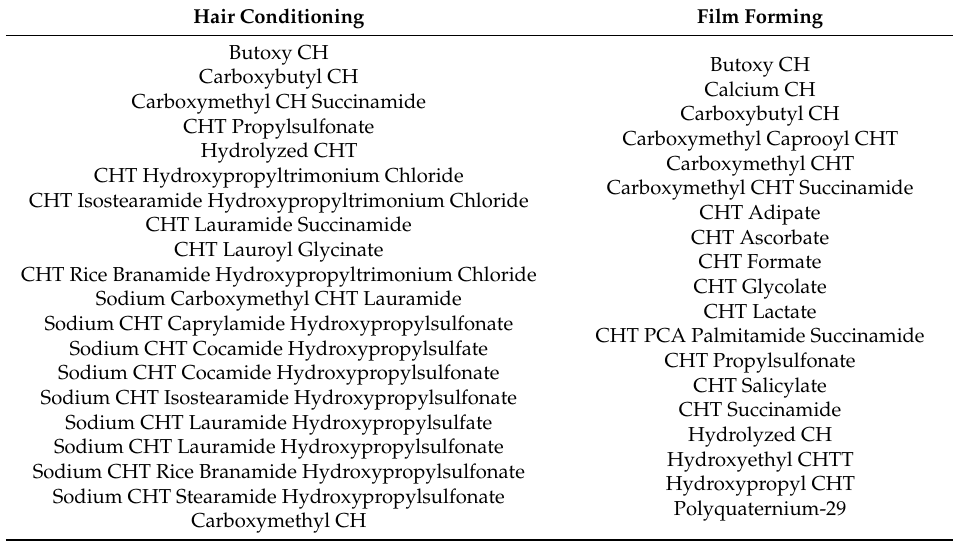
Table 8. Chitin and chitosan derivatives with hair conditioning and film forming functions according to CosIng